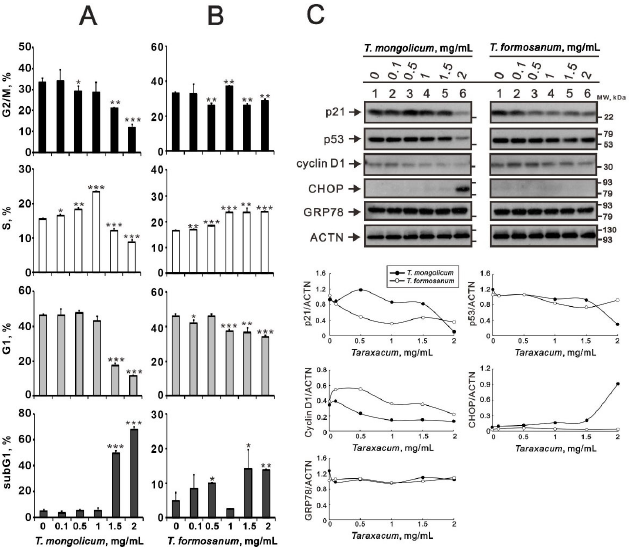
Figure 2. Cell cycle effects of T. mongolicum and T. formosanum on MDA ‐ MB ‐ 231 cells. MDA ‐ MB ‐ 231 cells were treated for 48 h with the indicated concentrations of ( A ) T. mongolicum or ( B ) T. formosanum . Cell cycle profiles were measured using flow cytometry after PI staining. The results were analyzed from three independent experiments. Symbols and bars depict the mean ±SD. * p < 0.05, ** p < 0.01, *** p < 0.001. ( C ) MDA ‐ MB ‐ 231 cells were treated for 24 h with the indicated concentrations of T. mongolicum or T. formosanum . Cell lysates were subjected to Western blot analysis using antibodies against p21, p53, and cyclinD1. ACTN was the protein loading control. Protein bands were quantified through pixel density scanning and evaluated using ImageJ, version 1.44a (http://imagej.nih.gov/ij/)(accessed on 25 July 2022).